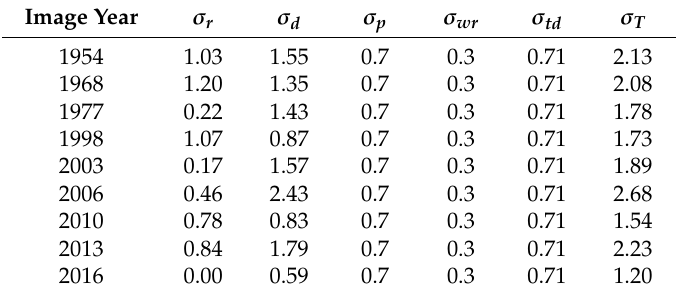
Table 1. Uncertainty associated with sampling errors and natural variability (units in